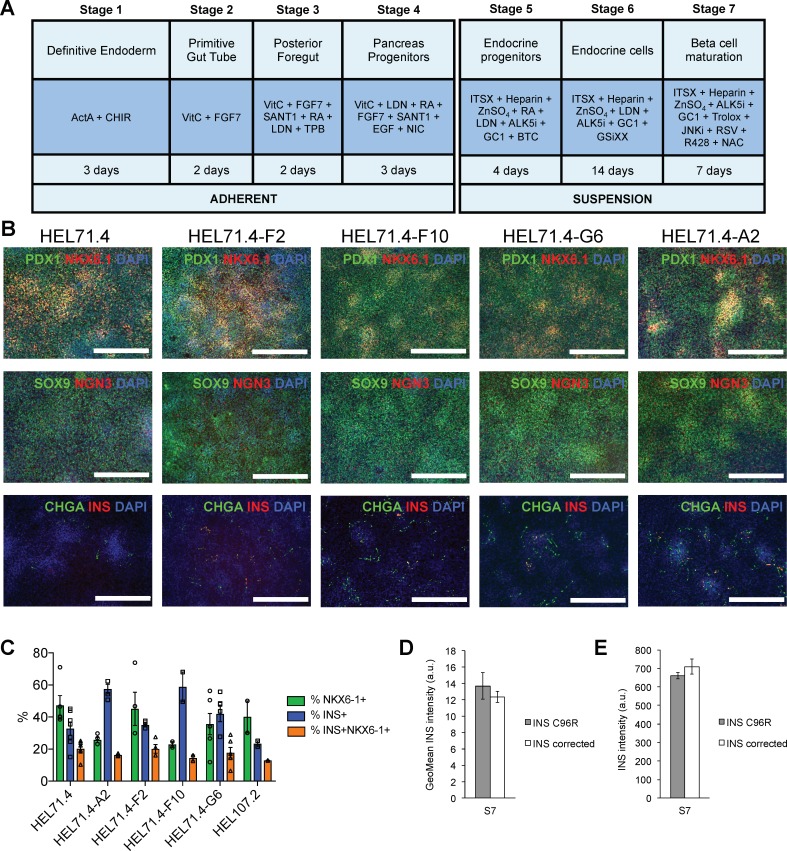
Differentiation efficiency of HEL71.4 mutant and corrected cell lines.(A) Outline of the iPSC to beta cell differentiation protocol. (B) Immunocytochemistry for pancreatic progenitor markers PDX1, NKX6.1, SOX9 and NGN3 and endocrine markers CHGA and INS at the end of Stage 4. (C) Cytometry for NKX6.1 and INS of INS mutant (HEL71.4 and HEL107.2) and INS corrected iPSC lines differentiated to Stage 7. (D) Quantification by cytometry of INS staining intensity in S7 INS+ cells for INS C96R and INS corrected cells. Data represent mean ± SEM, n = 7–9. (E) Quantification of INS staining intensity from S7 immunostainings for INS C96R and INS corrected cells. Data represent mean ± SEM, n = 7–9.